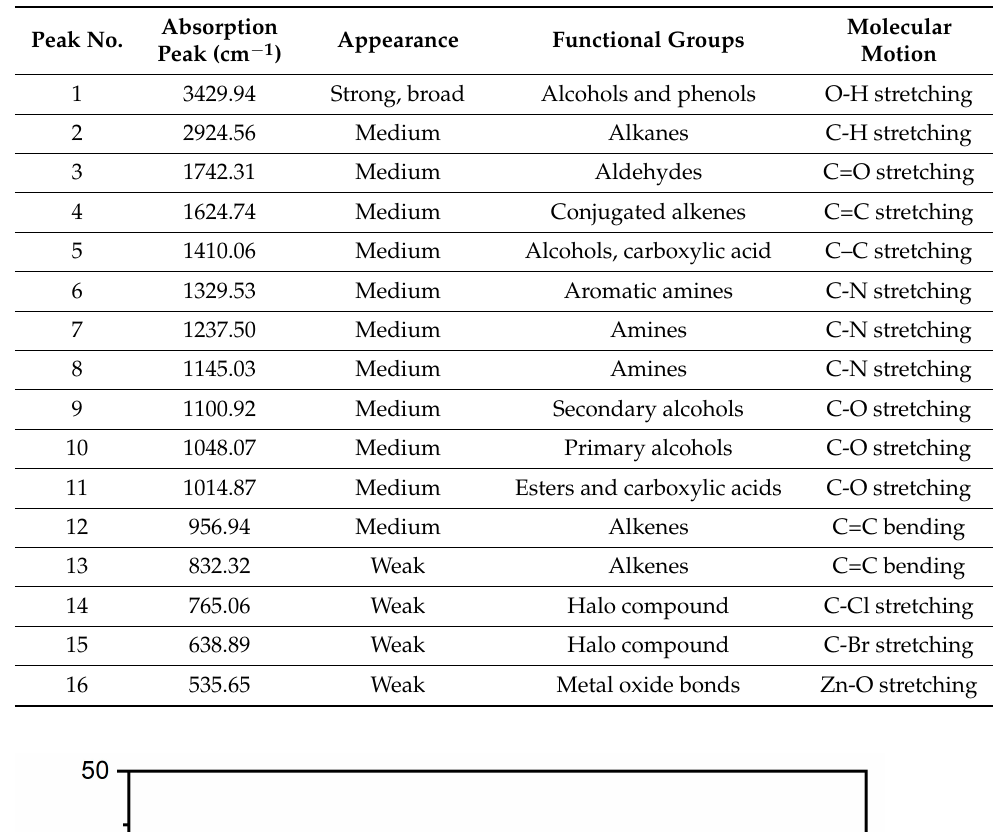
Table 1. Functional groups of ZnO-NPs detected by FTIR analysis.